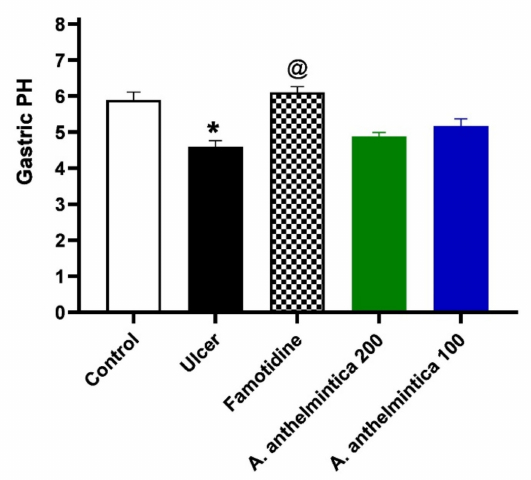
Figure 4. Effects of indomethacin alone or with oral pre-treatments of famotidine, and A. anthelmintica extract (200, 100 mg/kg) on the gastric pH in rats. Statistical analyses were conducted utilizing one-way ANOVA followed by Tukey’s post hoc test, n = 6, mean ± SEM. * Significantly different from control group at p < 0.05. @ Significantly different from indomethacin alone group at p < 0.05.